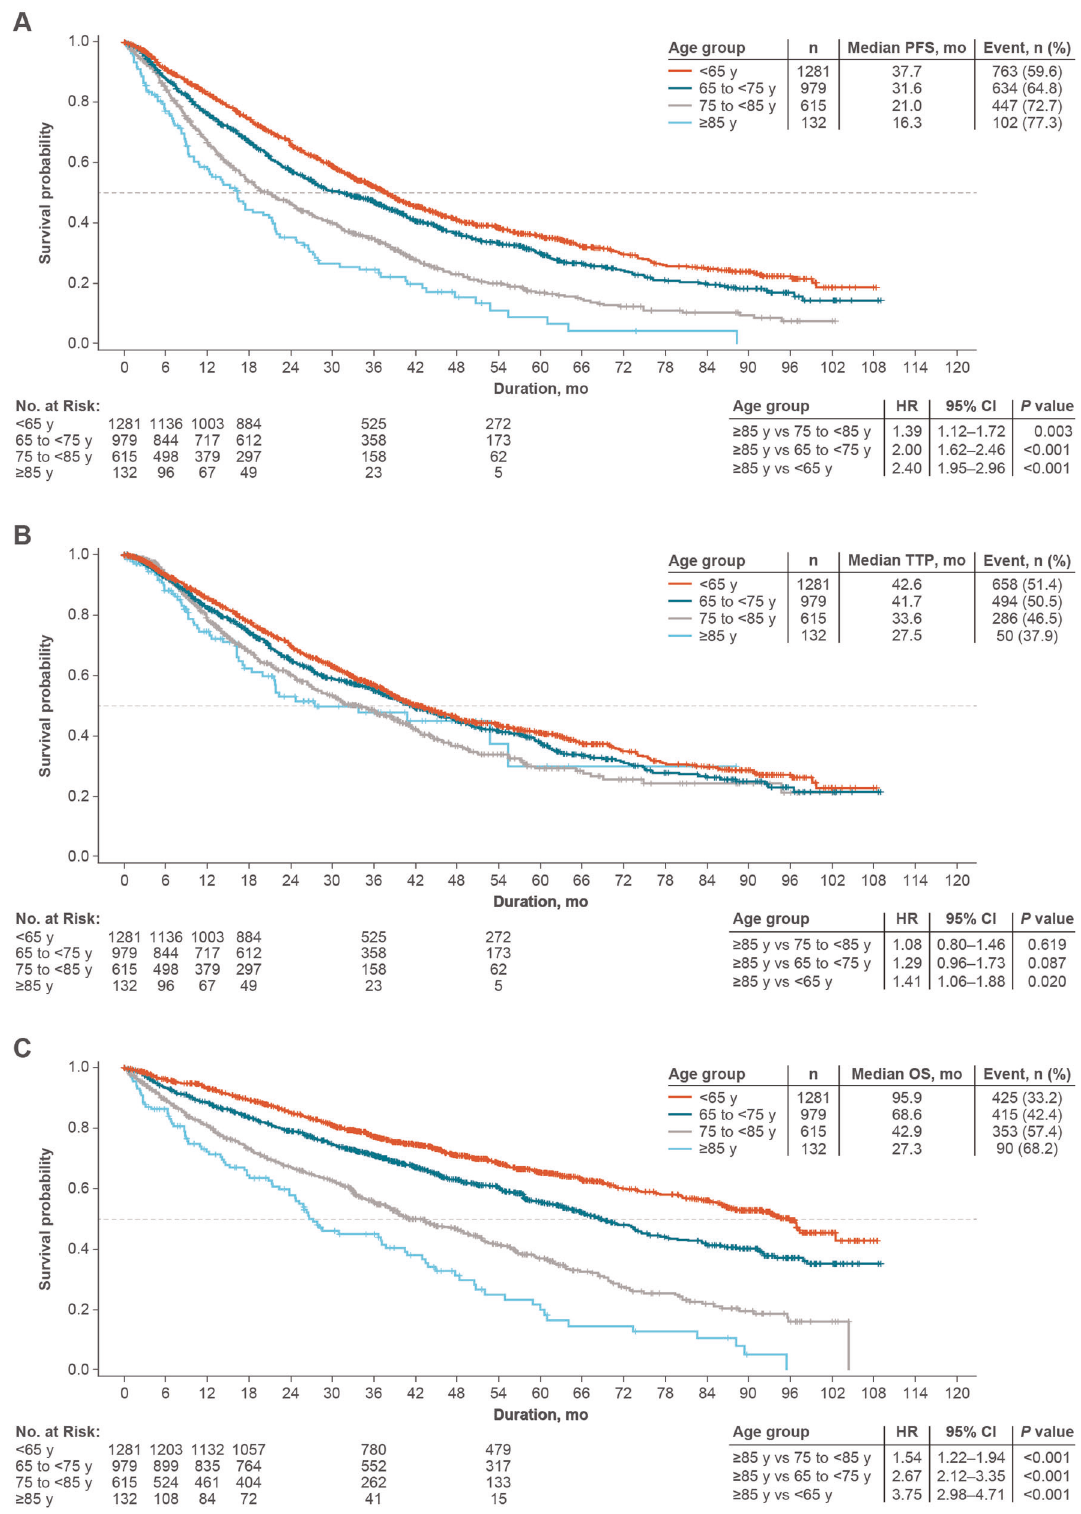
Fig. 1 Survival outcomes by age group. A Progression-free survival in 1 L. B Time to progression in 1 L. C Overall survival. OS overall survival, PFS progression-free survival, TTP time to